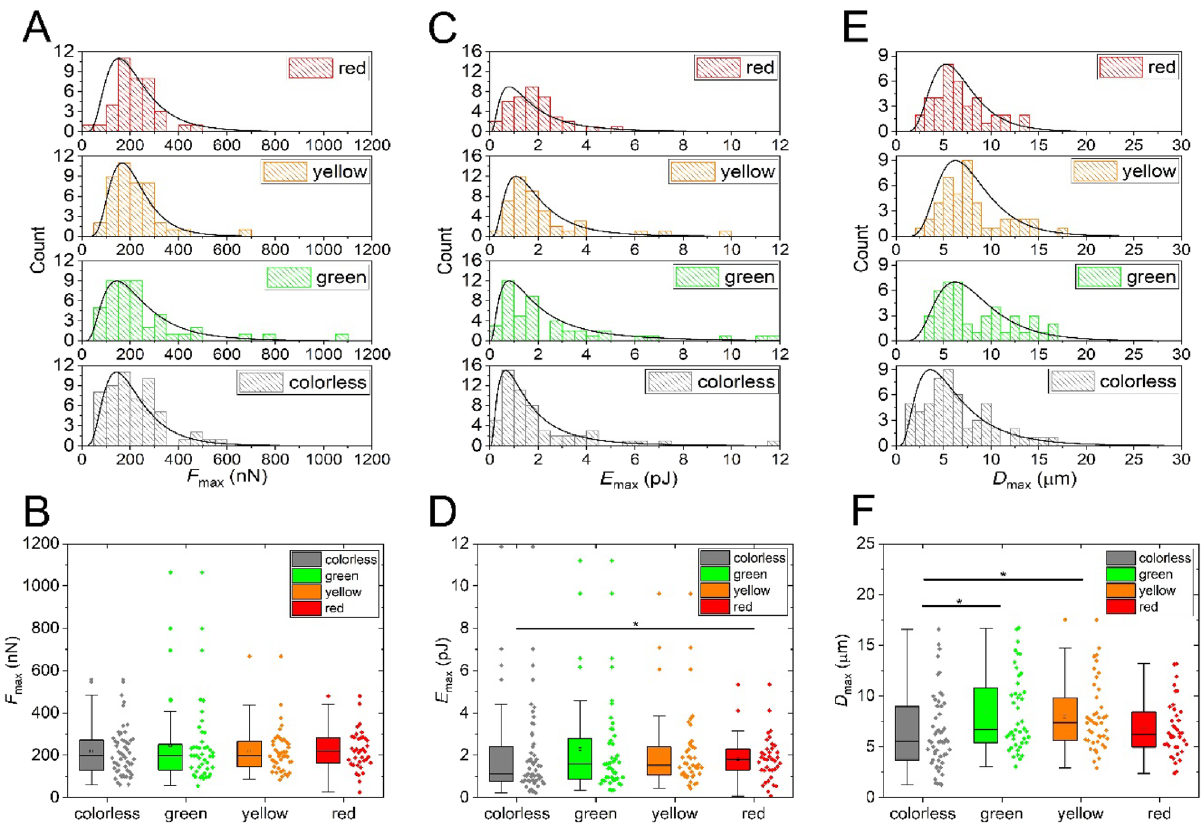
Figure 4. Adhesion parameter distributions with respect to cell color are presented on histograms with lognormal distribution ( A,C,E ) and box charts ( B,D,F ). Parameters F max ( A,B ) and E max ( C,D ) show no statistical difference between individual phase colors (except for a weak significance for the colorless-red E max, see Table S1), but D max ( E,F ) presents a difference between colorless (M phase), green (G2 phase), and yellow (S phase) cells ( p < 0.05). F max : colorless cells mean = 218 ± 16 nN; green cells mean = 252 ± 29 nN; yellow cells mean = 218 ± 16 nN; red cells mean = 222 ± 15 nN. E max : colorless cells mean = 1.9 ± 0.3 pJ; green cells mean = 2.6 ± 0.4 pJ; yellow cells mean = 2.1 ± 0.3 pJ; red cells mean = 1.8 ± 0.2 pJ. D max : colorless cells mean = 6.4 ± 0.5 µm; green cells mean = 6.4 ± 1.8 µm; yellow cells mean = 8 ± 0.5 µm; red cells mean = 6.8 ± 0.5